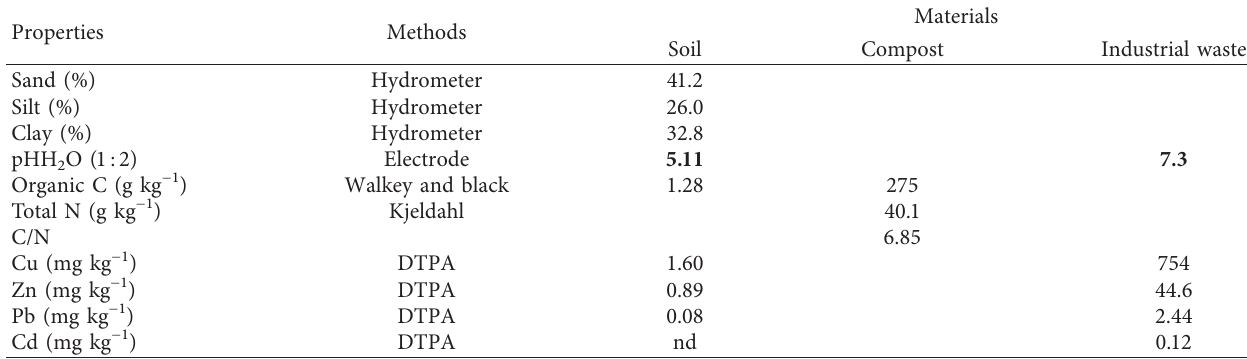
Table 1: Selected initial properties of materials used in the